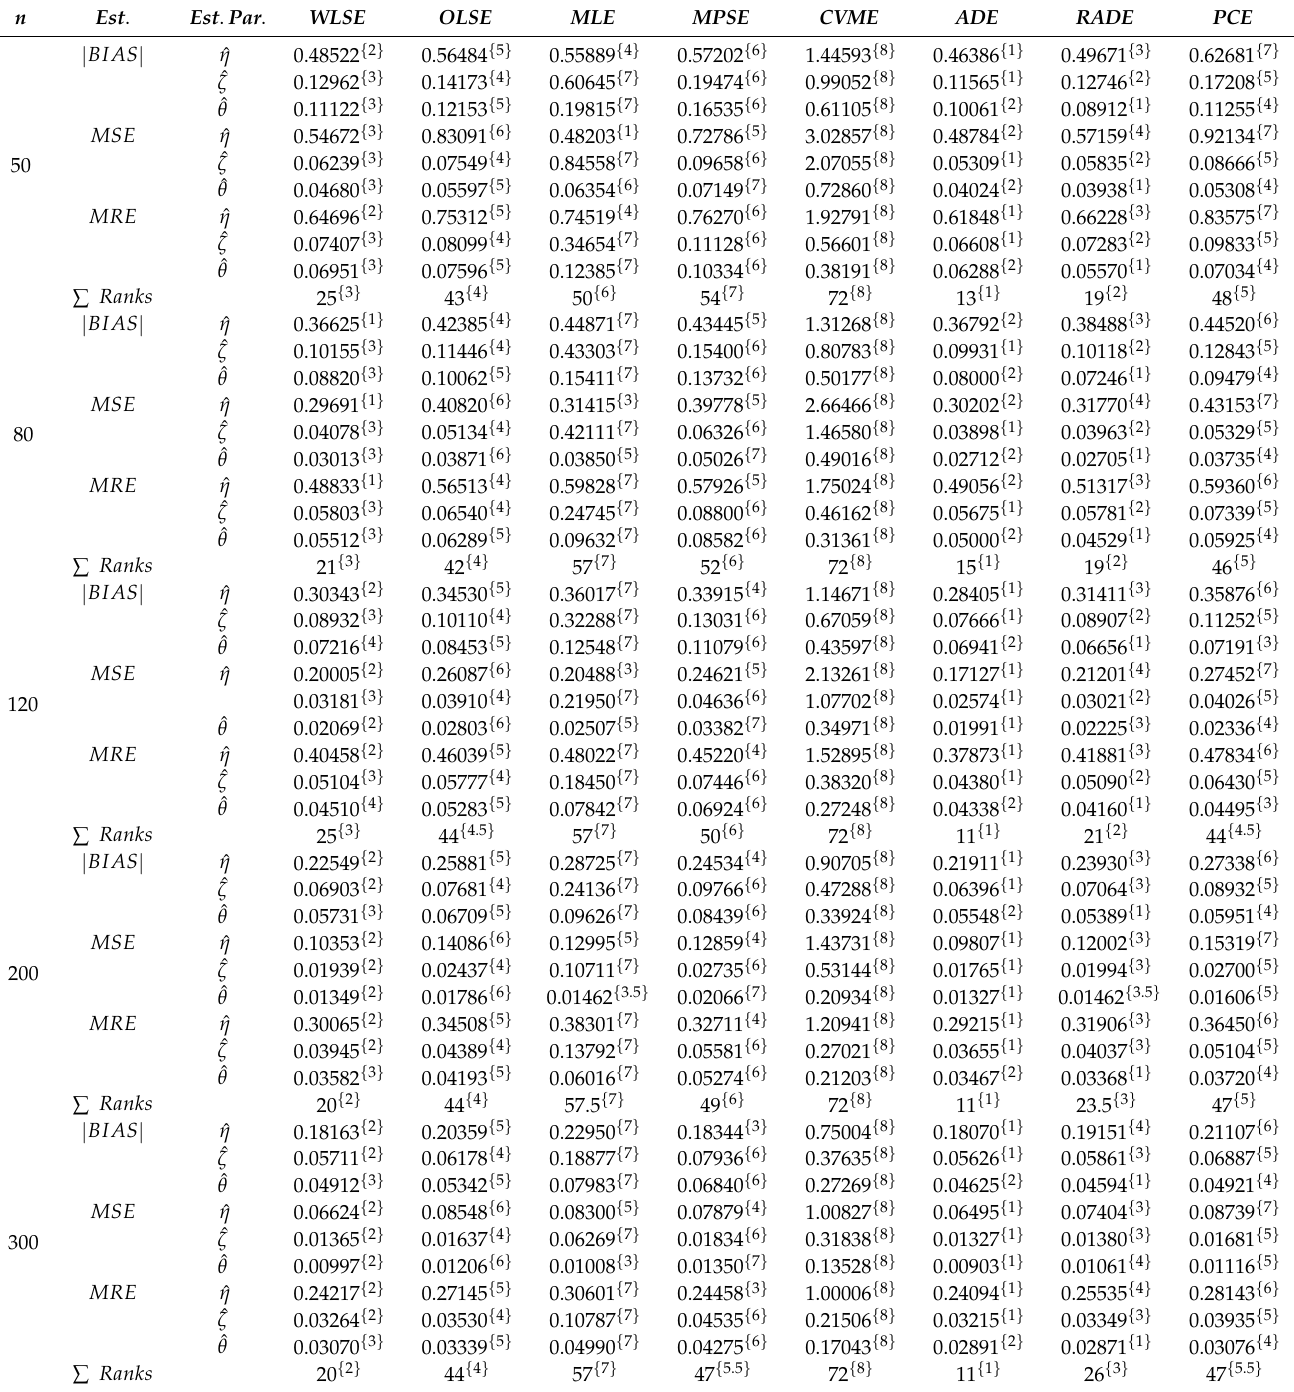
Table 6. Simulated results of the E-NPF distribution for Θ = ( η = 0.75, ζ = 1.75, θ = 1.60 ) T